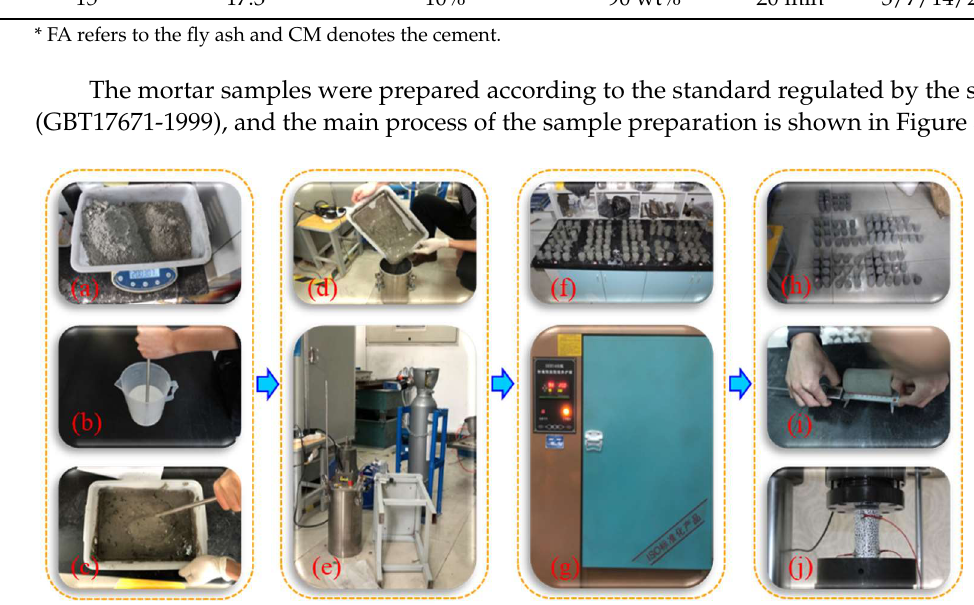
Figure 3. The process of CMFB specimen preparation and the mechanical